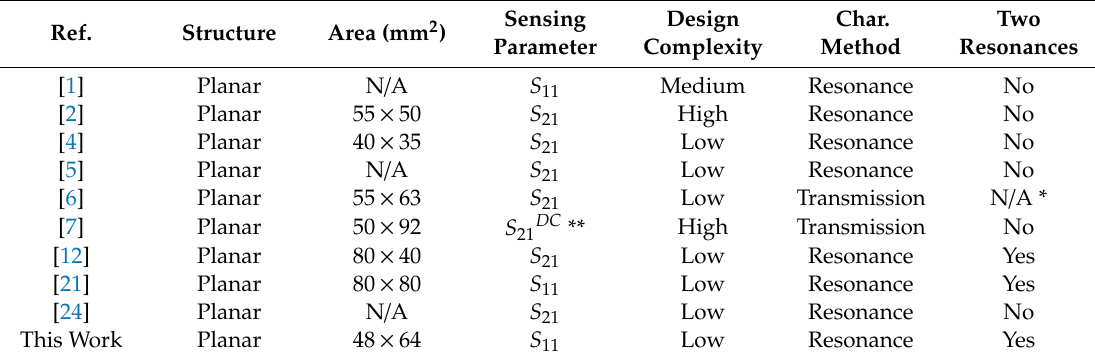
Table 7. Comparison of structural parameters with sensors reported in the literature.